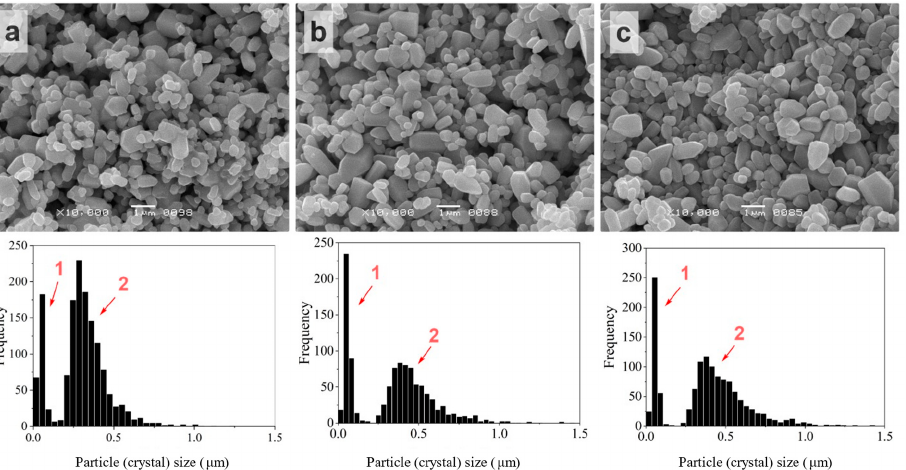
Figure 5. SEM images and crystal size distributions of ZnO powder after ZnAc introduction by impregnation combined with TVT: ZnO@AcZnTVT(0.5%) ( a ), ZnO@AcZnTVT(2.5%) ( b ), ZnO@AcZnTVT(5%) ( c ). 1 and 2 indicated fine and coarse components of size distributions, corre- spondingly.